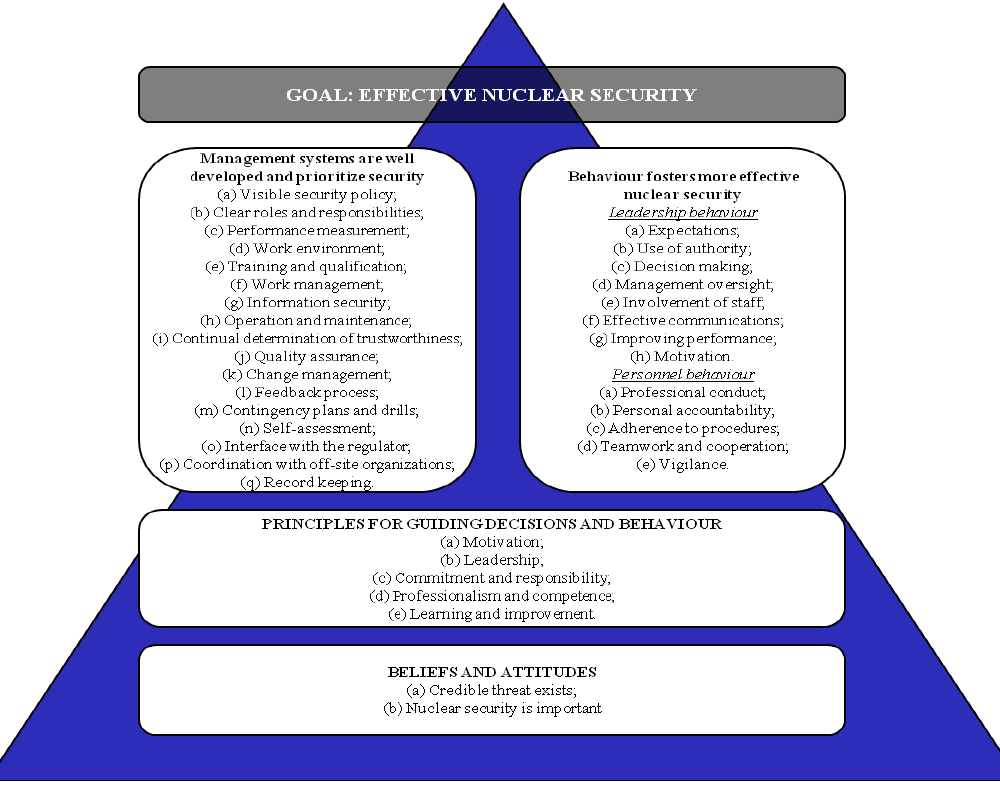
Figure 1. Characteristics of Nuclear Security Culture [ 5 ]